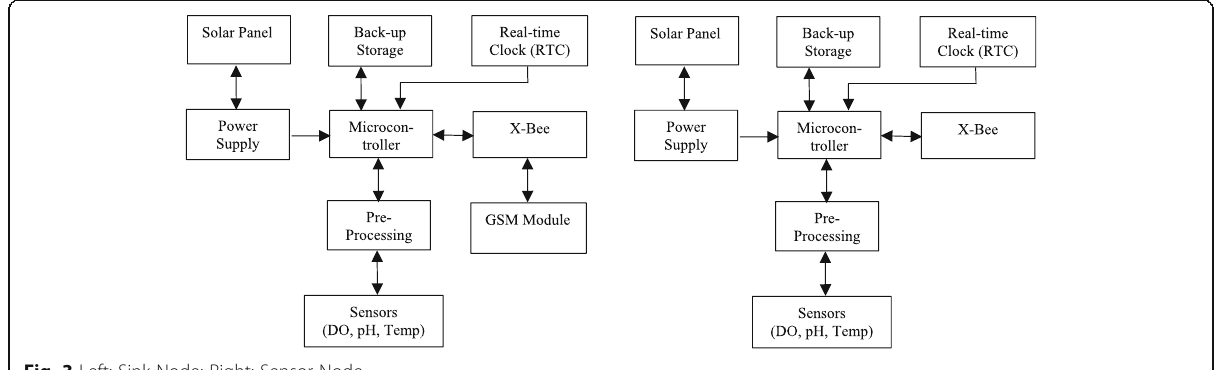
Fig. 3 Left: Sink Node; Right: Sensor